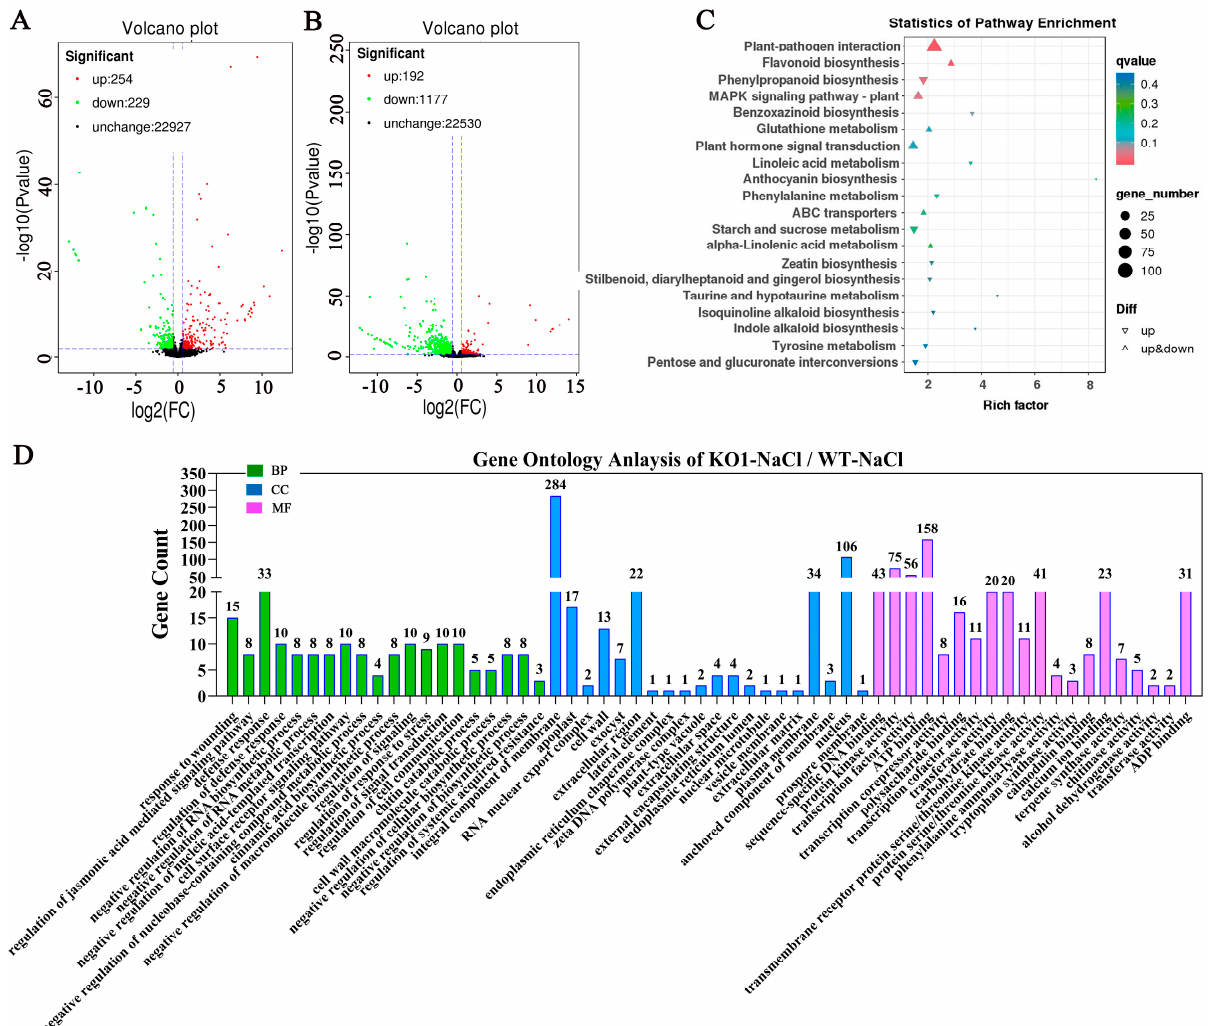
Figure 10. GO and KEGG enrichment analyses of DEGs detected in WT and KO1 plants under salt stress. ( A – B ) Volcan plots of DEGs detected under normal conditions ( A ) and salt stress conditions ( B ). ( C ) KEGG enrichment analysis of DEGs detected under salt stress conditions. ( D ) Categorization and functional annotation of DEGs. The different categories were as follows: biological process ( green columns ), cellular component ( blue columns ), and molecular function ( purple columns ).